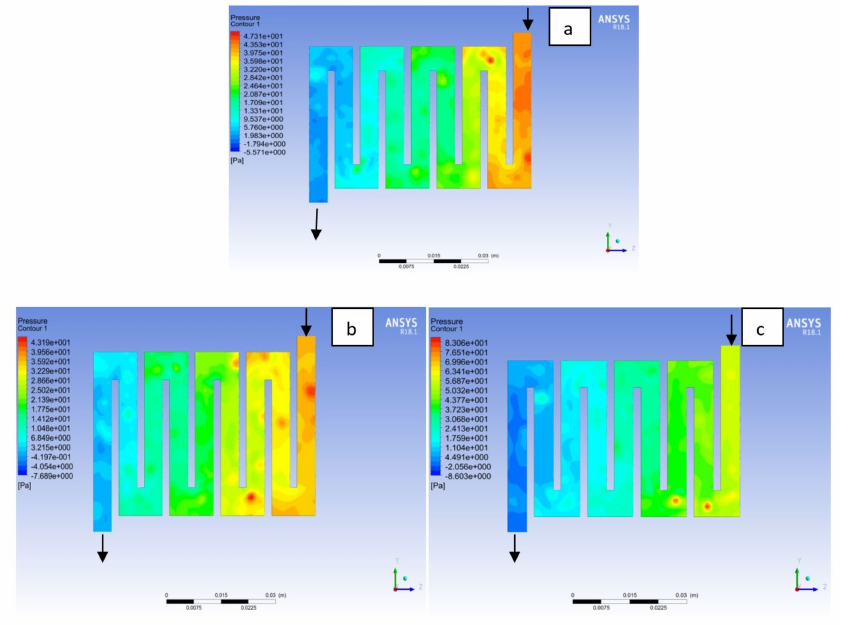
Figure 11. Pressure distribution at the cathode region (GDL/CL) for each material with temperature 323 K at 1.5 bar: ( a ) Aluminum, ( b ) Copper, ( c )